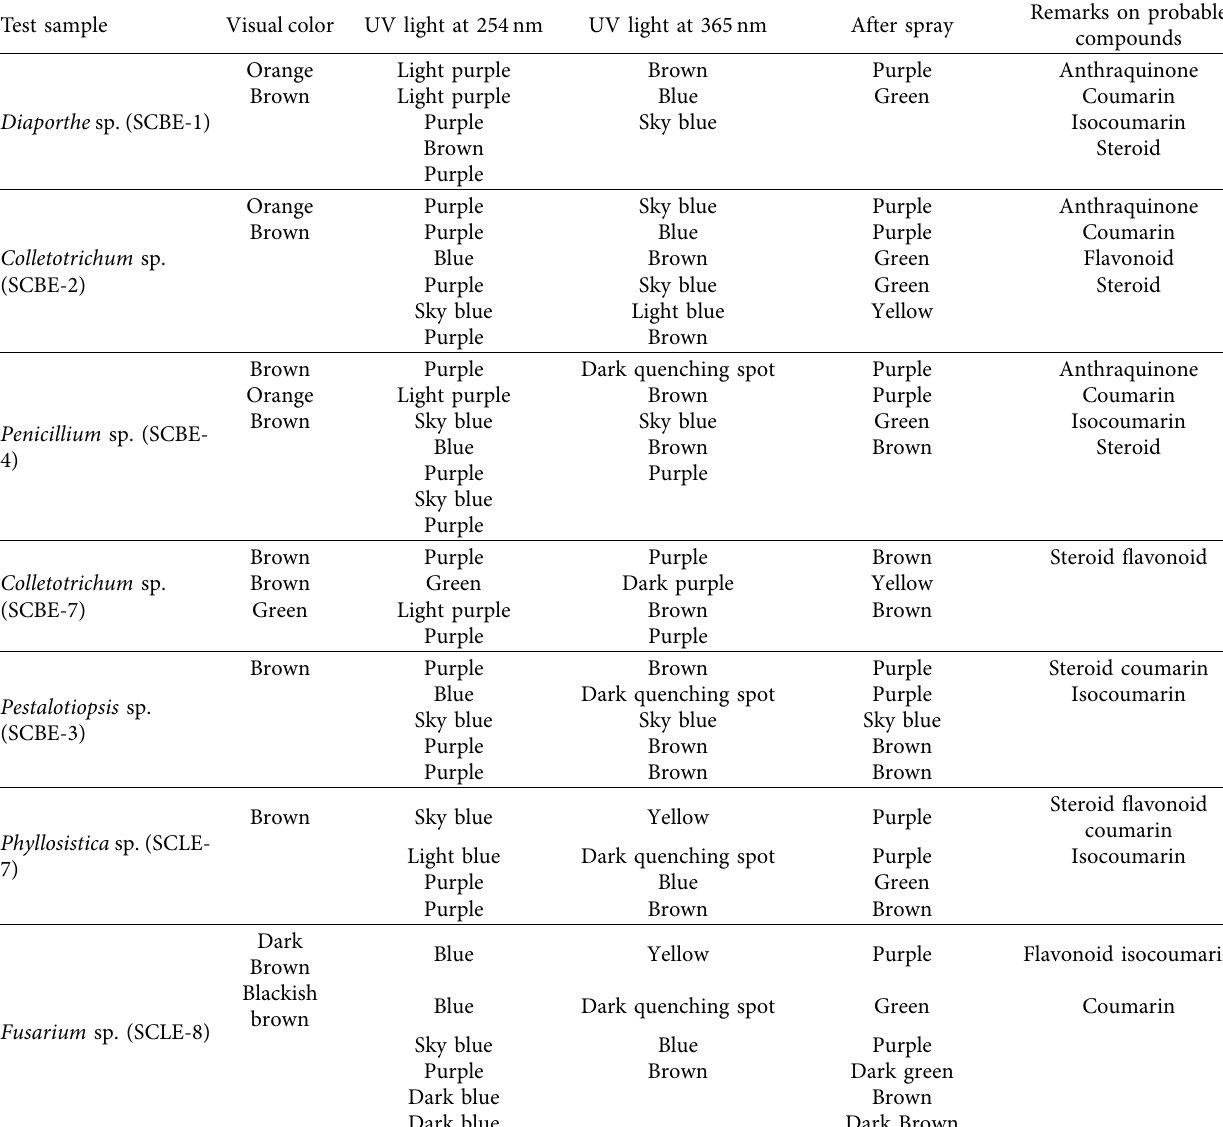
Table 2: Preliminary chemical screening of fungal isolates and plant extracts. Test